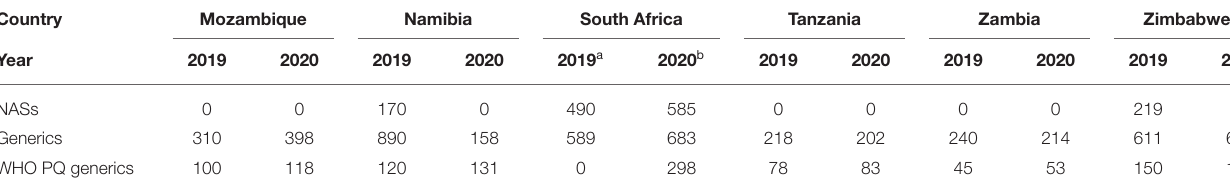
TABLE 2 | Comparison of mean approval times of NASs, generics and WHO prequalified generics 2019–2020 (calendar days).